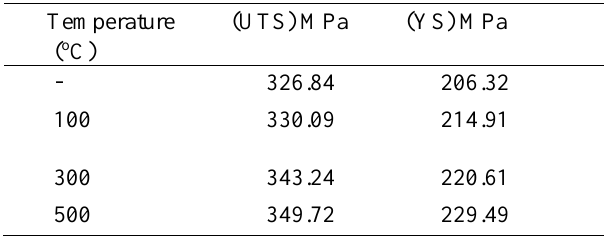
UTS and YS of unquenched non-heated/heated mild steel samples